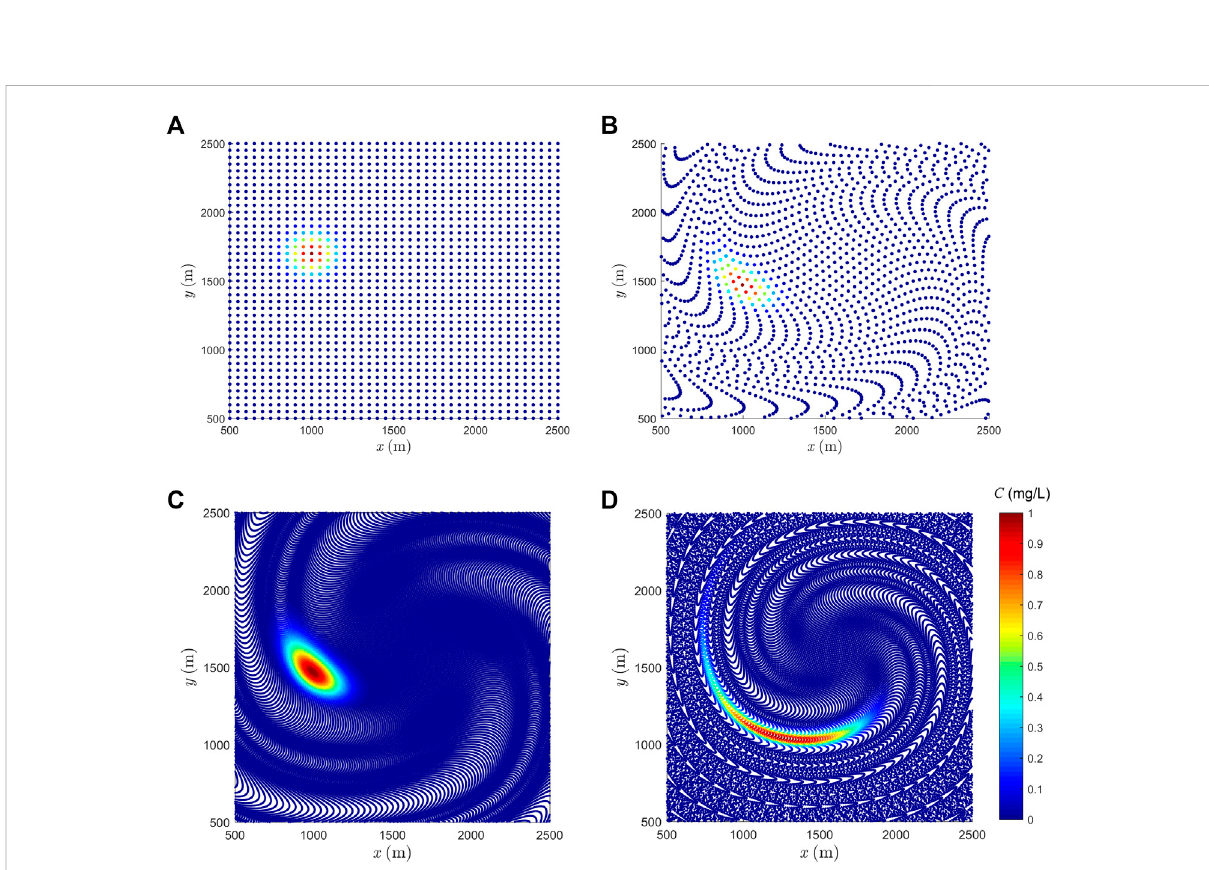
FIGURE 4 Pure advection simulation by SPH: concentration and particle distribution. (A) t = 0 s and 4096 particles, (B) t = 3400 s (roughly one rotation) and 4096 particles, (C) t = 3400 s and 102400 particles and (D) t = 6800 s and 102400 particles.